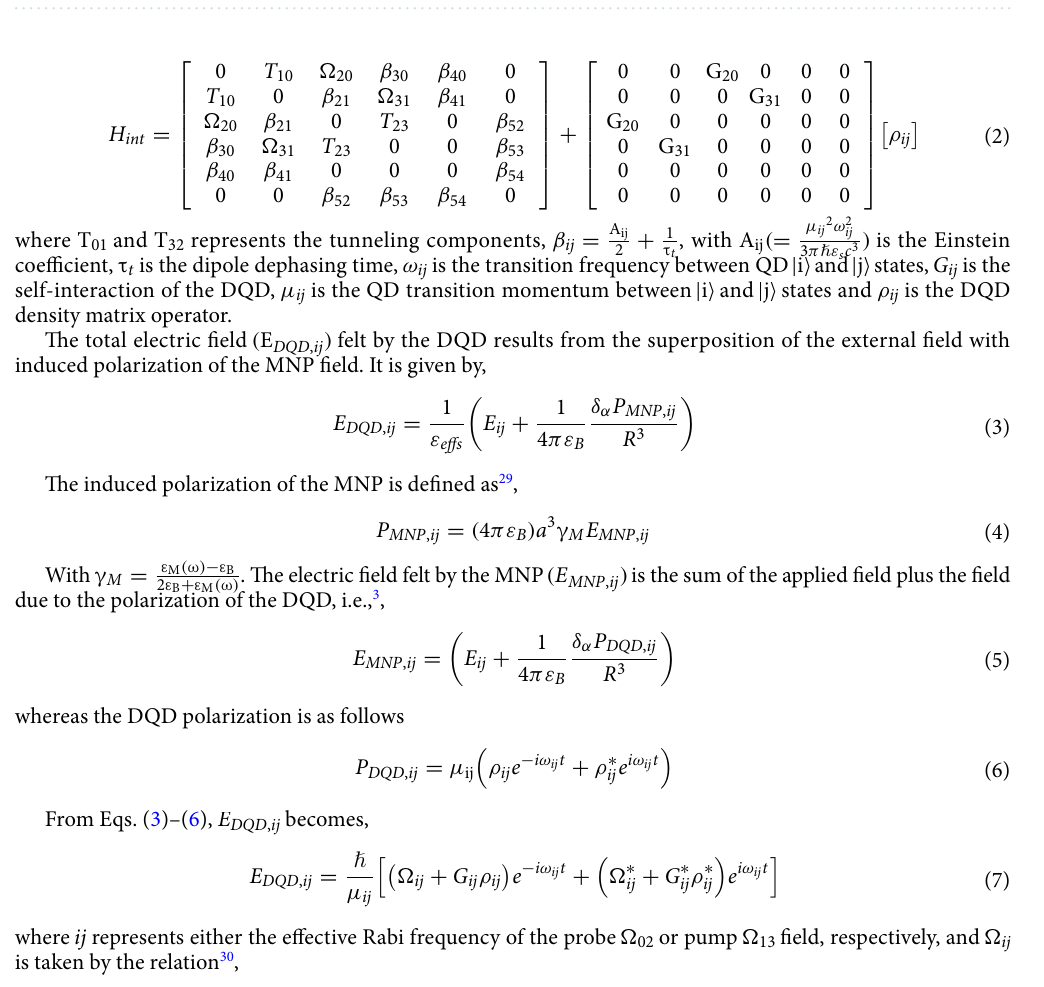
Figure 2. Energy band diagram for the DQD-MNP system with